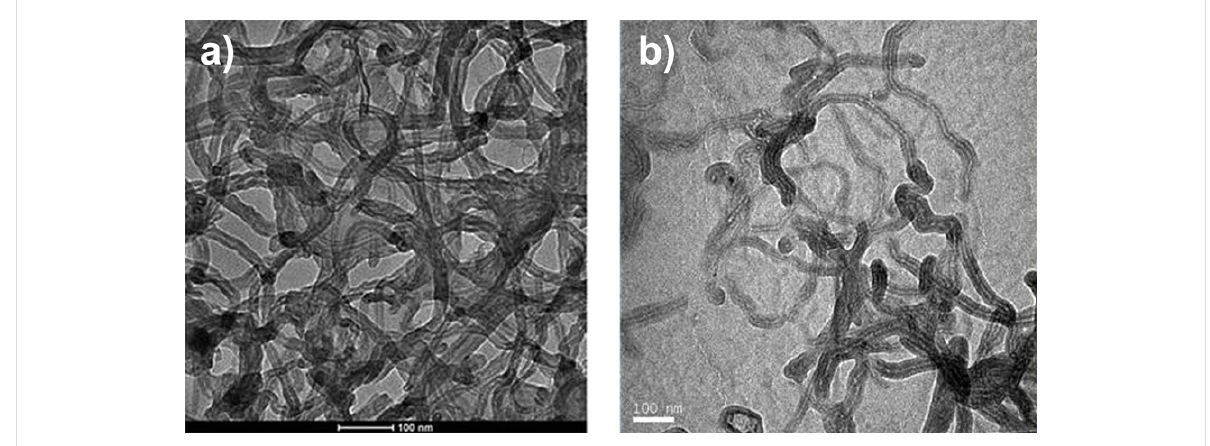
Figure 2: TEM micrographs of CNTs dispersion spray obtained by means of: the ultrasonic atomizer a); the airbrush b). Scale bars: 100 nm.